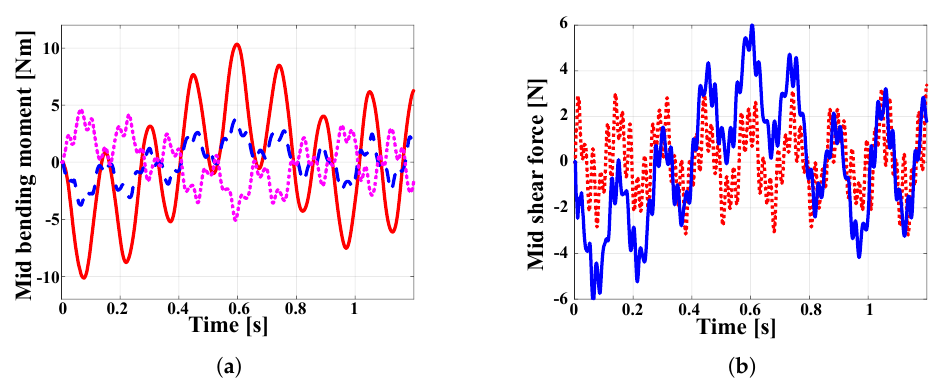
Figure 7. Stress resultant histories at the center of the plate. ( a ) Bending moments: M 11 , solid line; M 22 , dotted line; M 12 , dashed line. ( b ) Shear forces: Q 1 , dotted line; Q 2 , solid line.